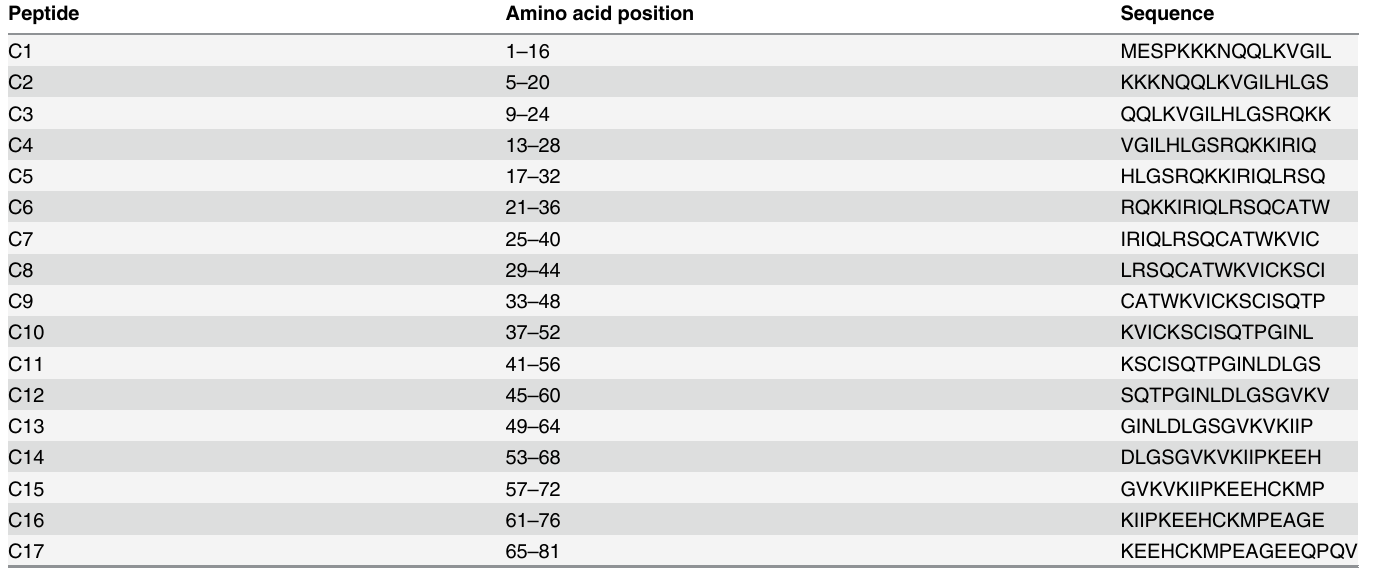
(Table 1) spanning the entire amino acid sequence of the XAGE-1b protein, rhIL-2 (50